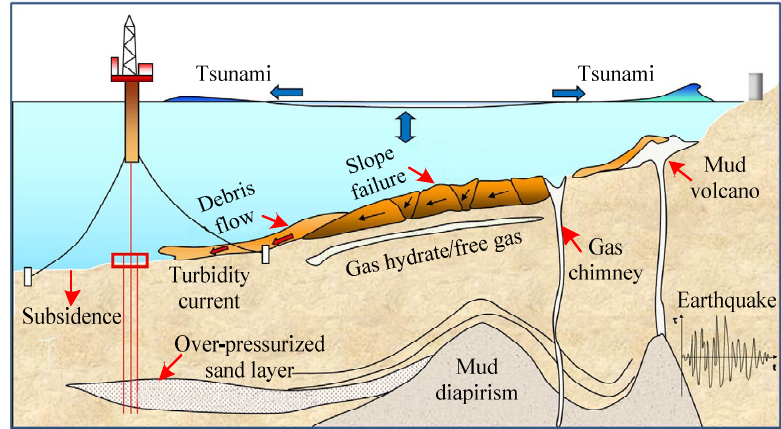
Figure 5. Sketch map of marine geohazards [22].